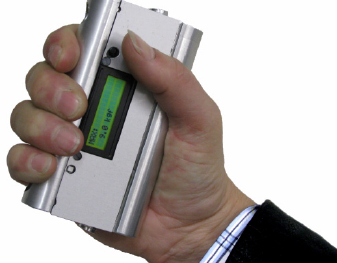
Figure 3. Small, accurate, digital, auto-ranging and light Handgrip